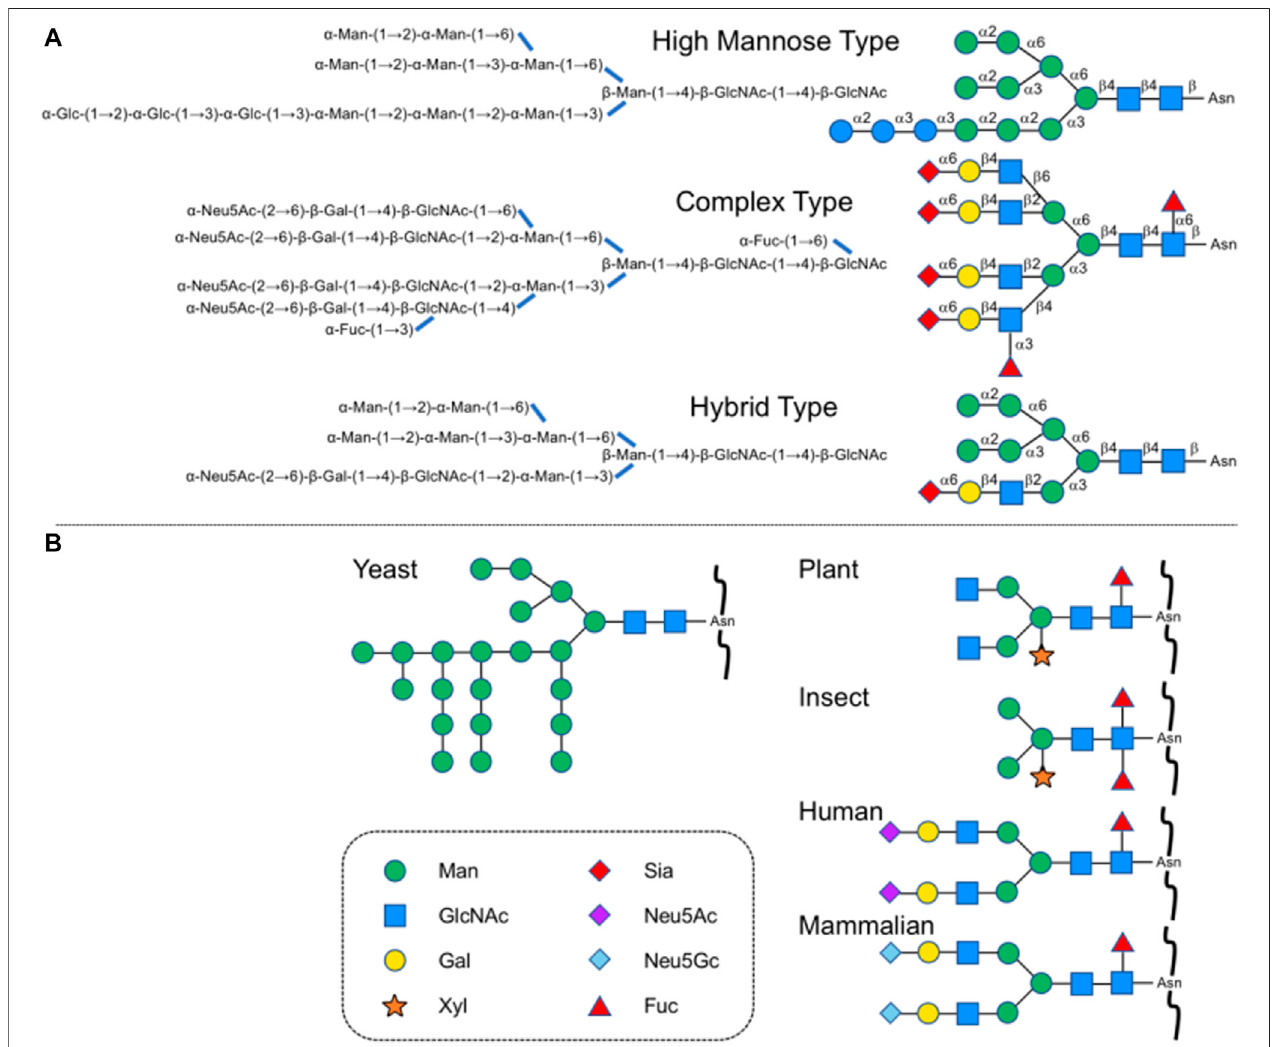
FIGURE 1 | (A) Typical N -glycan subtypes in yeast and a mammalian cell. (B) Typical N -glycan structures in other species.